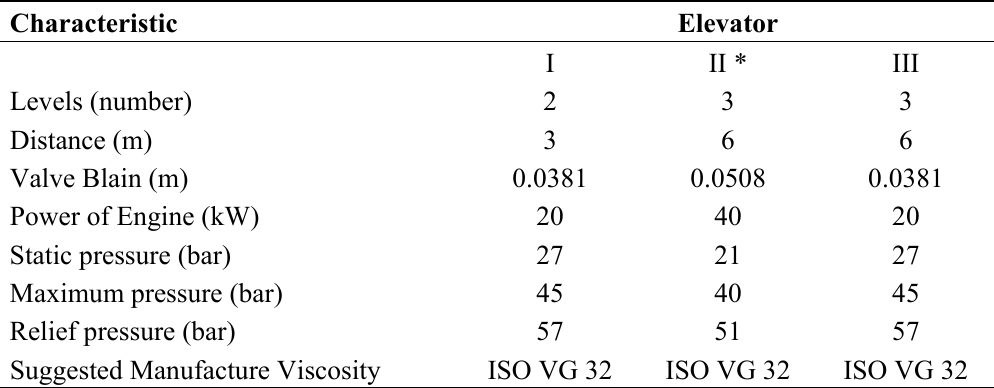
Table 1. Technical Characteristics of the examined